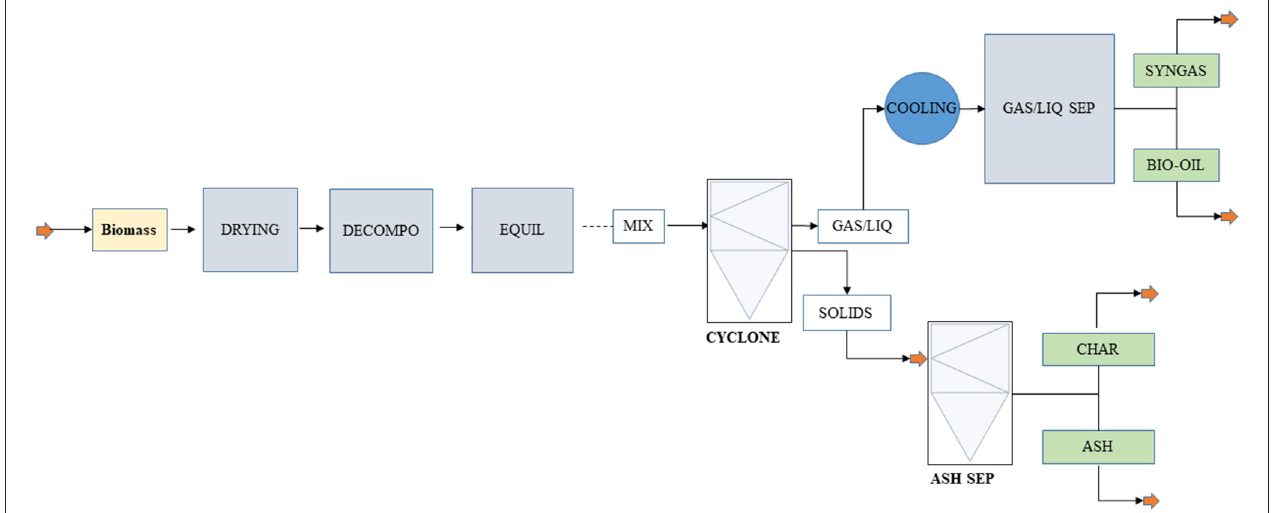
FIGURE 1 | Flowsheet of the fruit wastes pyrolysis process.